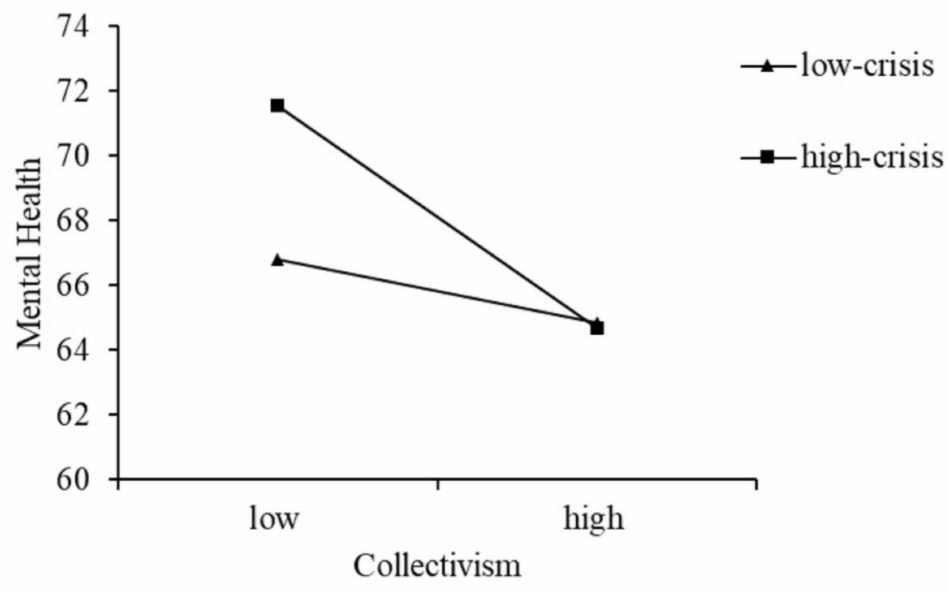
Figure 2. Moderating role of crisis in the relationship between collectivism and mental